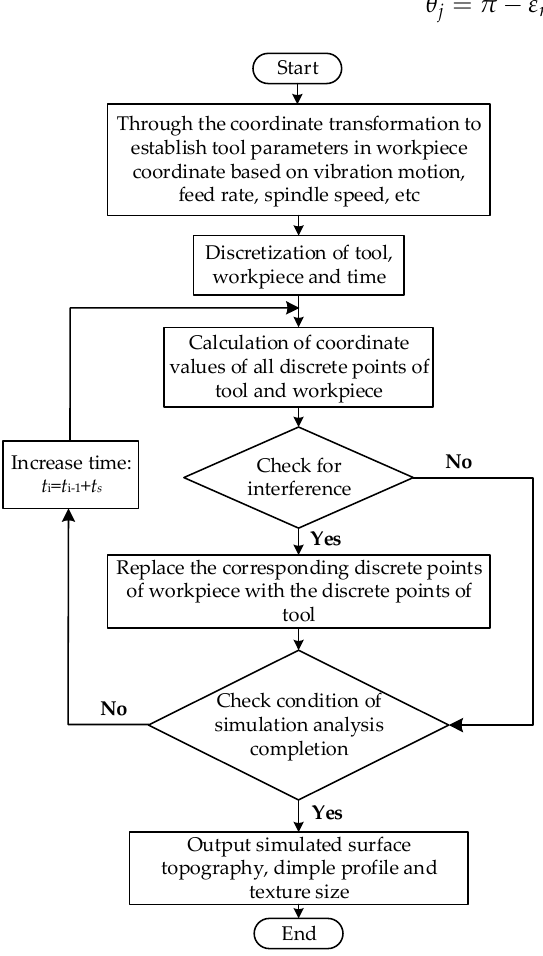
Figure 10. Flow chart of the simulation process.